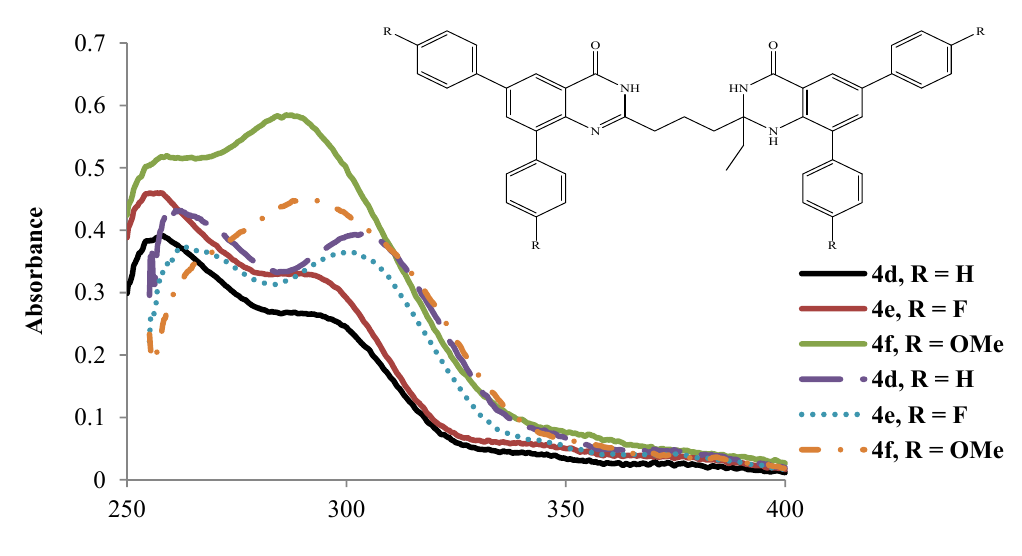
CO H (solid lines) at rt 3 2